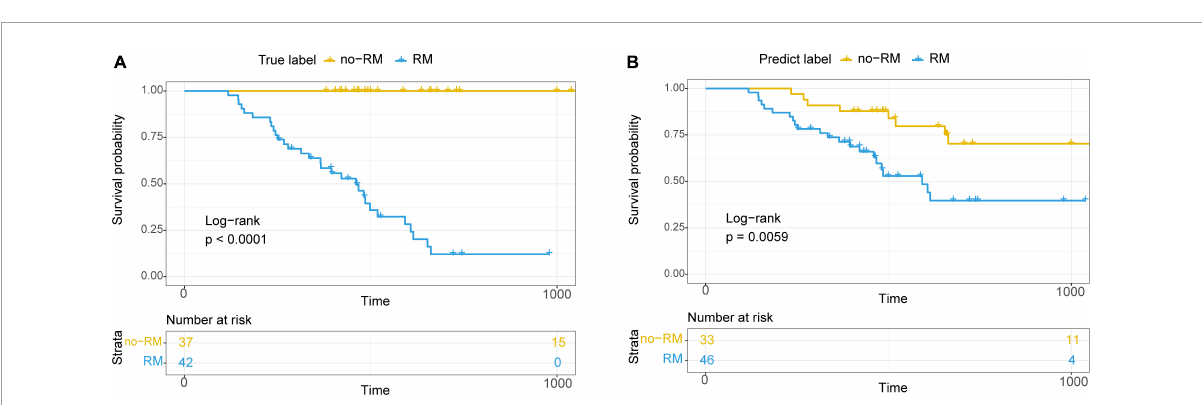
FIGURE6 Kaplan–Meier survival curve showed significantly different overall survival between RM and no-RM. (A) Relationship between true recurrence and metastasis labels and overall survival of patients. (B) Relationship between recurrence and metastasis labels predicted by the model and the overall survival of patients; RM, recurrence or metastasis; no-RM, without recurrence and